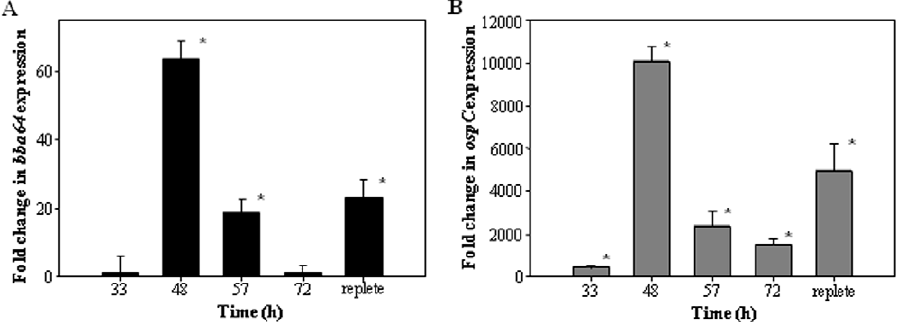
Figure 1. bba64 and ospC expression during nymphal tick feeding. Fold change in A) bba64 and B) ospC expression in actively feeding and replete WT-infected nymphs relative to flat nymphs. Data represents the average of 4 independent experiment samples per time point (each technically replicated in triplicate), and error bars correspond to the standard error of the means (SEM). Statistically significant differences (*) existed between baseline (0) and bba64 or ospC expression (P , 0.05) using Mann-Whitney rank sum test.